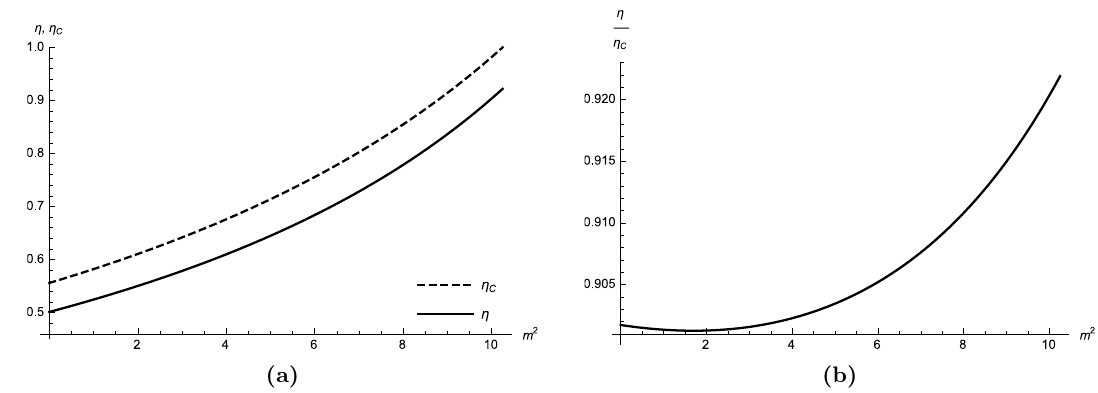
Figure 2 . A speci(cid:12)c example of four-dimensional charged black holes with the parameters chosen as k = 1 ; c 0 = 1 ; c 1 = (cid:0) 2 ; c 2 = (cid:0) 3 ; P 1 = 2 ; P 4 = 1 ; Q = 1 ; S 1 = 8 ; S 2 = 10. (a) (cid:17); (cid:17) C as the function of m 2 . (b) (cid:17)=(cid:17) C as the function of m 2